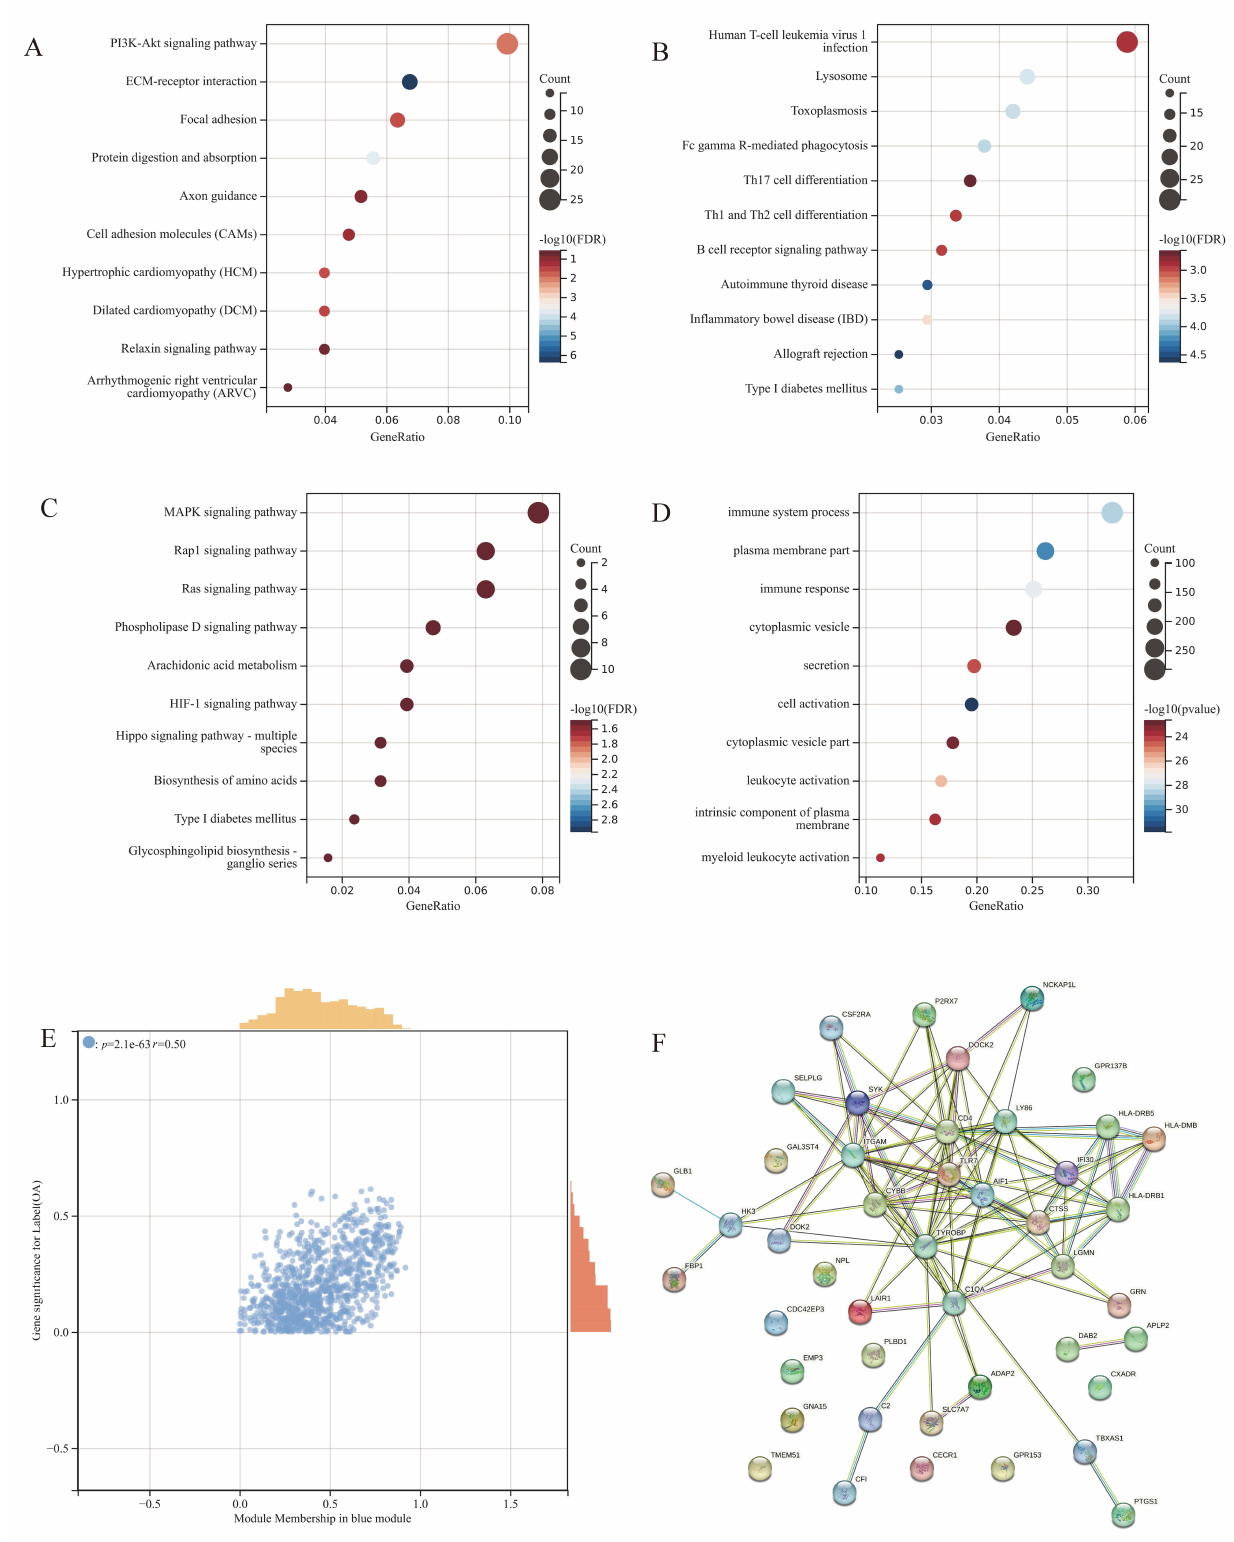
Figure 5. Functional and pathway enrichment and module screen: KEGG enrichment of the light- yellow module ( A ) KEGG enrichment of the blue module ( B ) KEGG enrichment of the light-green module ( C ) GO enrichment of the blue module ( D ) GS − MM correlation scatter plot of the blue module ( E ) PPI network of hub genes ( F